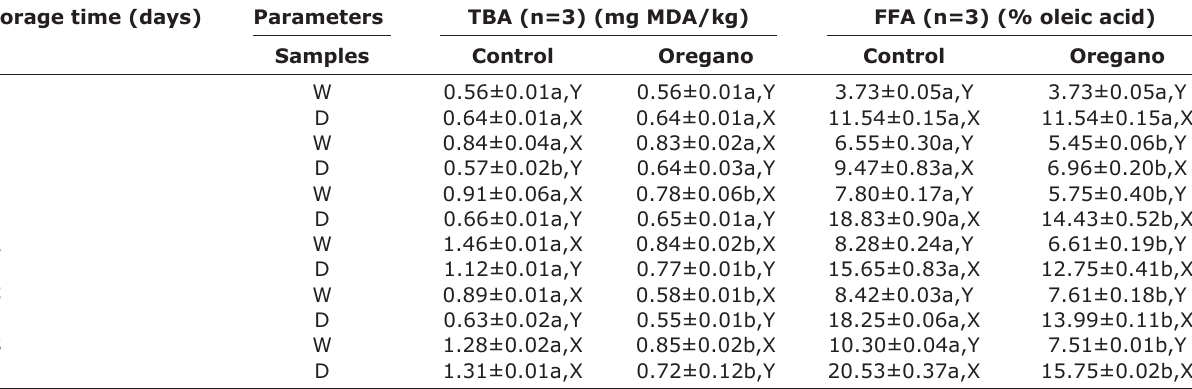
Table-2: Effect of oregano extract with vacuum-packaging on TBA and FFA in white (W) and dark (D) muscles of frigate tuna fillets stored at refrigerated (3±1°C) conditions. Storage time